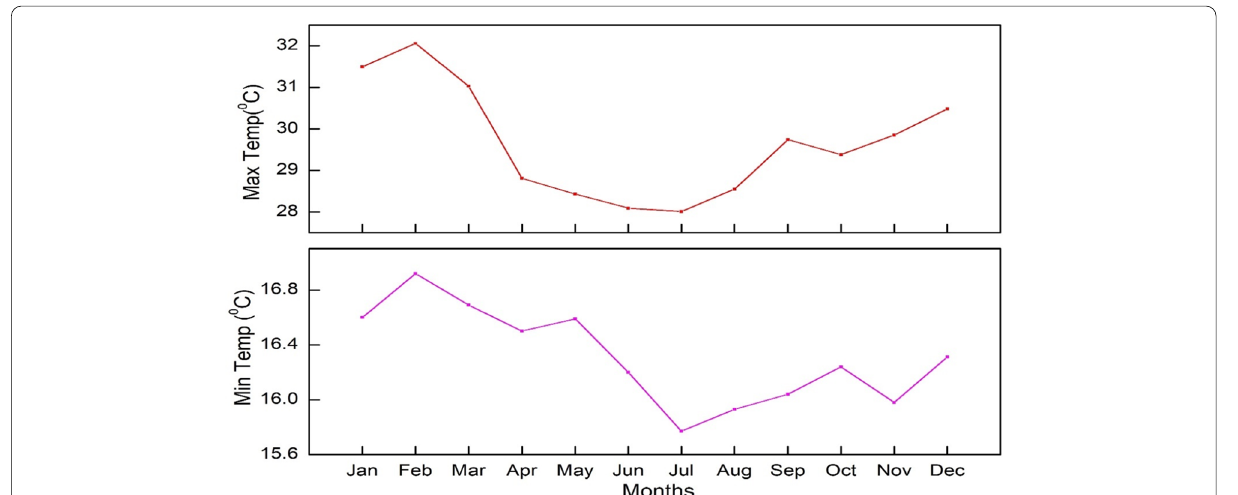
Fig. 4 Mean monthly Tmax and Tmin in semi-arid Borana (1981–2018)